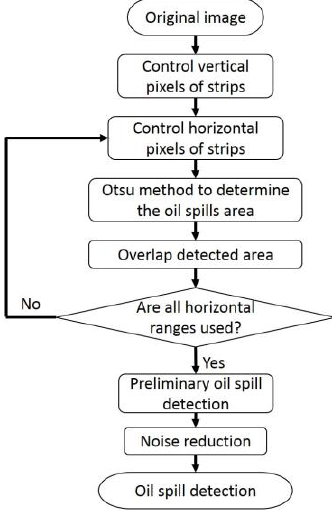
Figure 10. Data processing of the improved adaptive enhancement.